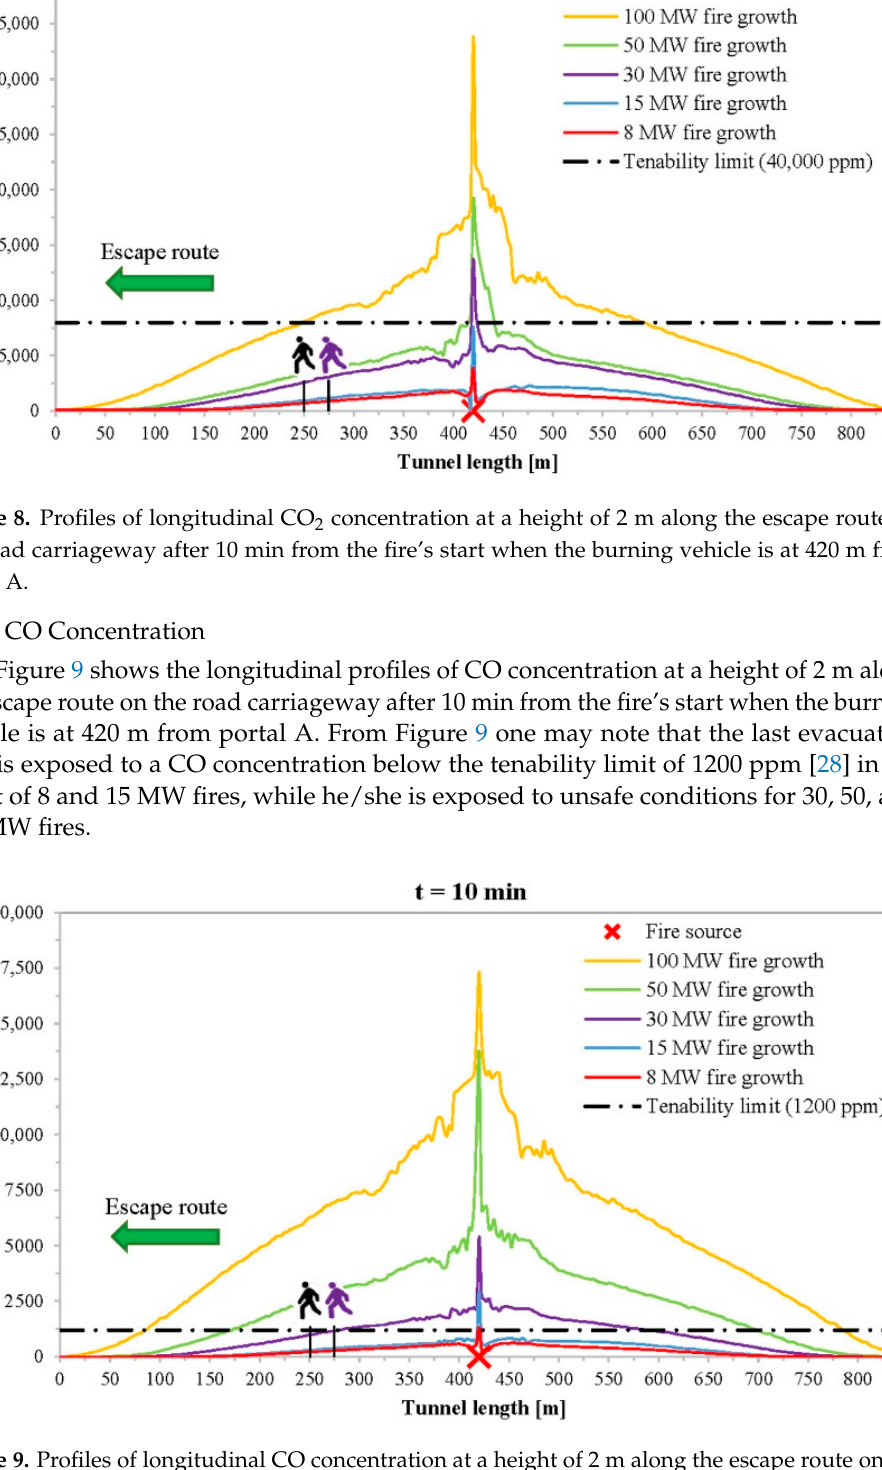
Figure 9. Profiles of longitudinal CO concentration at a height of 2 m along the escape route on the road carriageway after 10 min from the fire’s start when the burning vehicle is at 420 m from portal